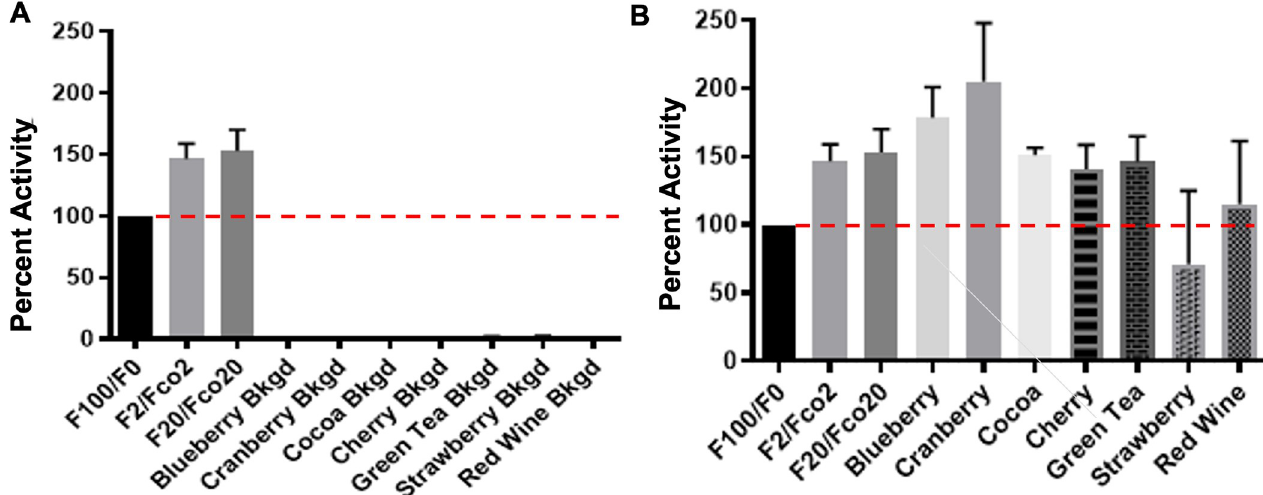
Fig 9. NAMPT activation by natural products. (A) NAMPT Activity background control, using only natural products as the source of NAMPT enzyme. (B) NAMPT activity using recombinant human NAMPT enzyme supplemented with natural products. Each bar represents the average of three independent trials, normalized for intrinsic fluorescence of natural product.